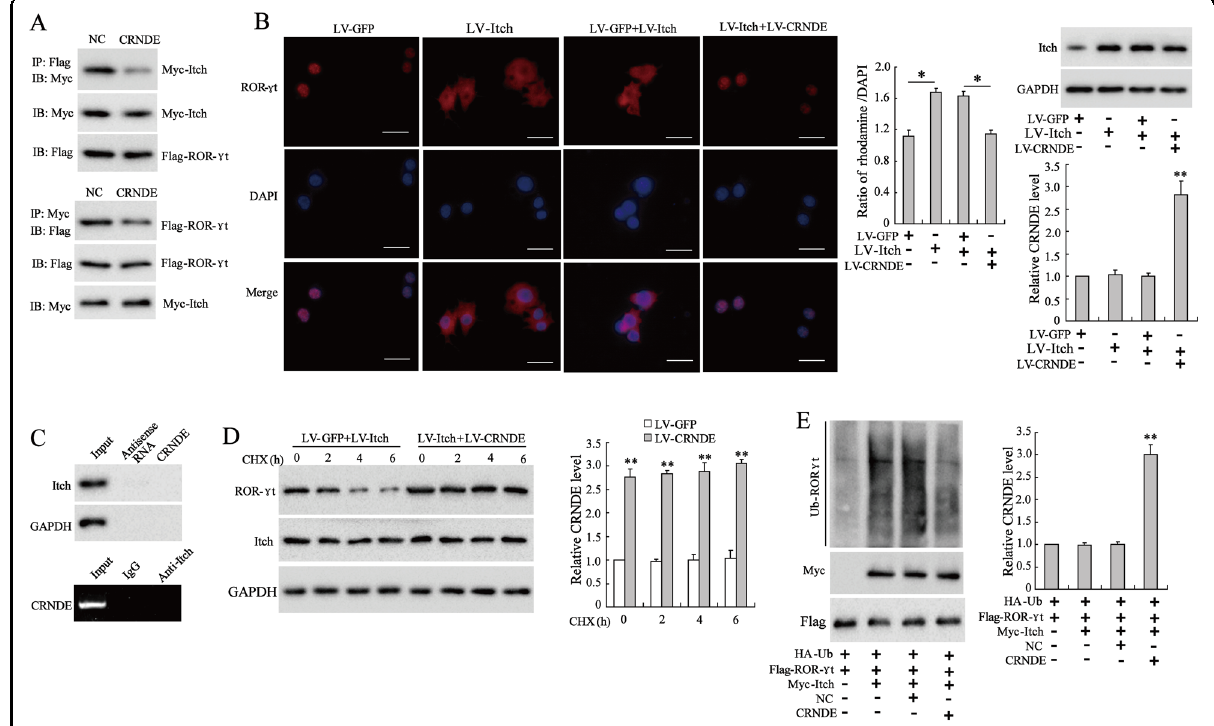
Fig. 6 CRNDE-h inhibited Itch-mediated ROR γ t ubiquitination and degradation by blocking the binding of Itch to ROR γ t. A The 293 A cells were co-transfected CRNDE-h overexpression vector (LV-CRNDE-h), Flag-tagged ROR γ t (Flag-ROR γ t), and Myc-tagged Itch (Myc-Itch). Co-IP: the enrichment of Myc-Itch in the products immunoprecipitated by Flag antibody (left); the enrichment of Flag-ROR- γ in the products immunoprecipitated by Myc antibody (right). IP: immunoprecipitation; IB: immunoblotting; NC: negative control of LV-CRNDE-h. B Tumor-in fi ltrating T cells were transfected with LV-Itch alone or co-transfected with LV-Itch and LV-CRNDE-h. The location of ROR γ t in cells was displayed by immuno fl uorescent staining. Bars = 5 μ m. The ratio of rhodamine/DAPI was analyzed. * p < 0.05 vs. LV-GFP or LV-Itch + LV-CRNDE-h. Western blot was used to detect the expression of Itch, and qRT-PCR was used to detect the level of CRNDE-h. ** p < 0.01 vs. LV-Itch + LV-CRNDE-h. C The RIP and RNA pull-down assays were performed in tumor-in fi ltrating T cells. RNA pull-down (upper): the enrichment of Itch in the products pulled-down by CRNDE- h or its antisense RNA. RIP (lower): the enrichment of CRNDE-h in the products immunoprecipitated by anti-Itch or anti-IgG. D Tumor-in fi ltrating T cells were co-transfected with LV-Itch and LV-CRNDE-h (or LV-GFP), and then were treated with cycloheximide (CHX) for indicated times (0, 2, 4, and 6 h). Later, the protein levels of ROR γ t and Itch were detected by western blot, and the level of CRNDE-h was detected by qRT-PCR. ** p < 0.01 vs. LV- GFP. E The 293 A cells were co-transfected with Myc-tagged Itch (Myc-Itch), Flag-tagged ROR γ t (Flag-ROR γ t), Lv-CRNDE-h, and HA-tagged ubiquitin (HA-Ub). Then the ubiquitination of ROR γ t was detected by immunoprecipitation assay. The level of CRNDE-h was detected by qRT-PCR. ** p < 0.01 vs.